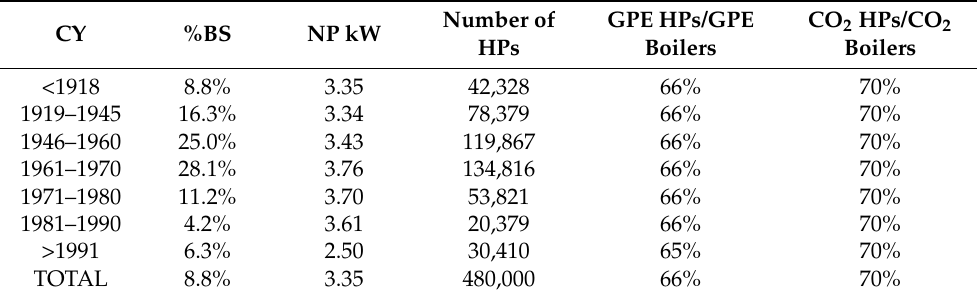
Table 7. Distribution, by building construction year CY in Milan, of the 480,000 selected HPs, percentage ratio of global primary energy from fossil fuels (GPE) and CO 2 emissions of heat pumps to that of boilers (generation fraction from RES 35%, grid losses 10%, COP at design temperature of − 5 ◦ C), portion of building stock %BS, nominal power